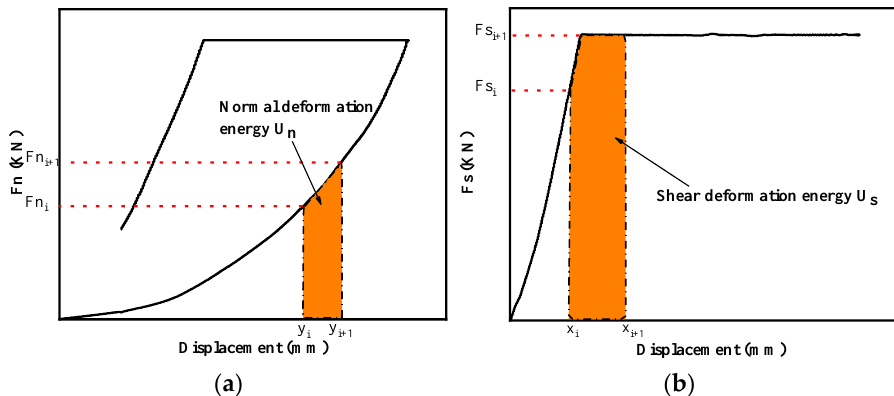
Figure 16. Calculation of energy by differential method. ( a ) Normal deformation energy U n . ( b ) Shear deformation energy U s.